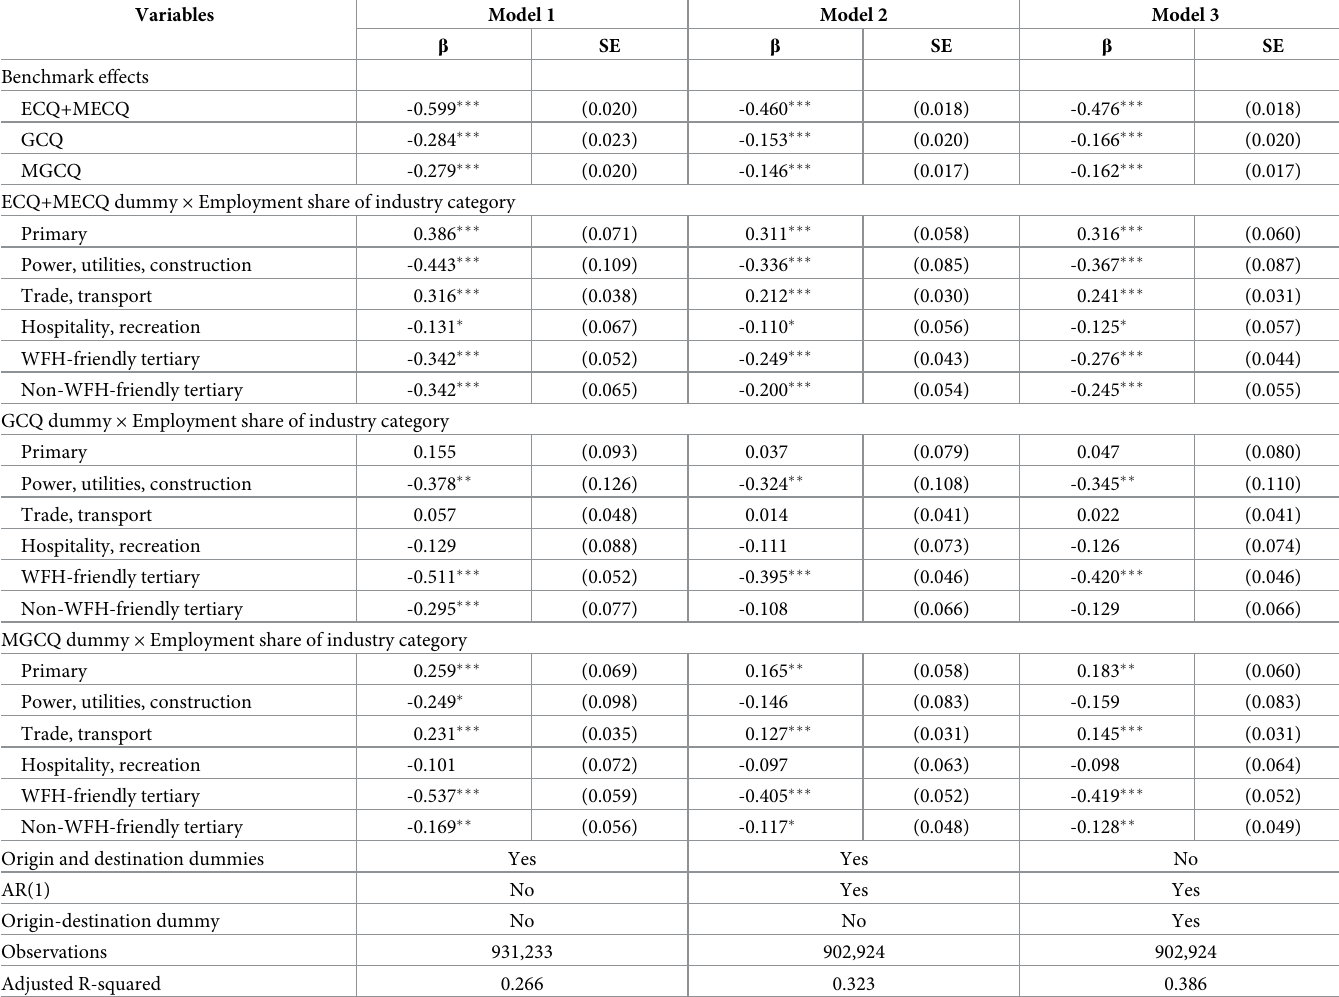
Table 3A. Effects of lockdown measures by destination city industrial composition (excluding within-barangay flows).